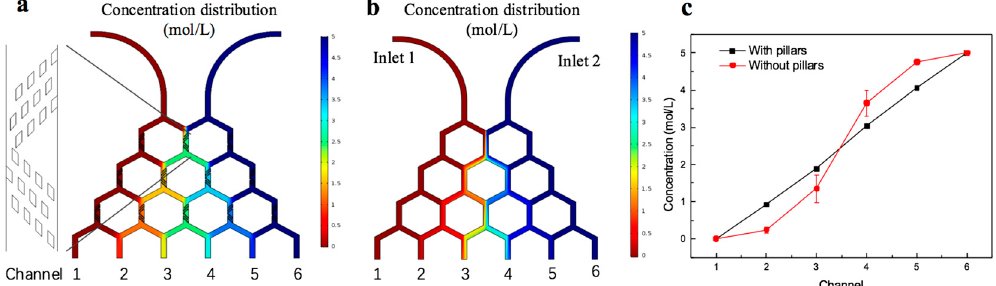
Figure 2. The simulation of concentration distribution in surface field. ( a ) The honey-comb structure with micropillar arrays. ( b ) The honey-comb structure without micropillar arrays. ( c ) The linearity of the concentration outflow from the 6 outlets of the structures with micropillar and without micropillar arrays. R 2 is 0.998. The error bar is standard deviation calculated by the concentration distribution of the outlet.